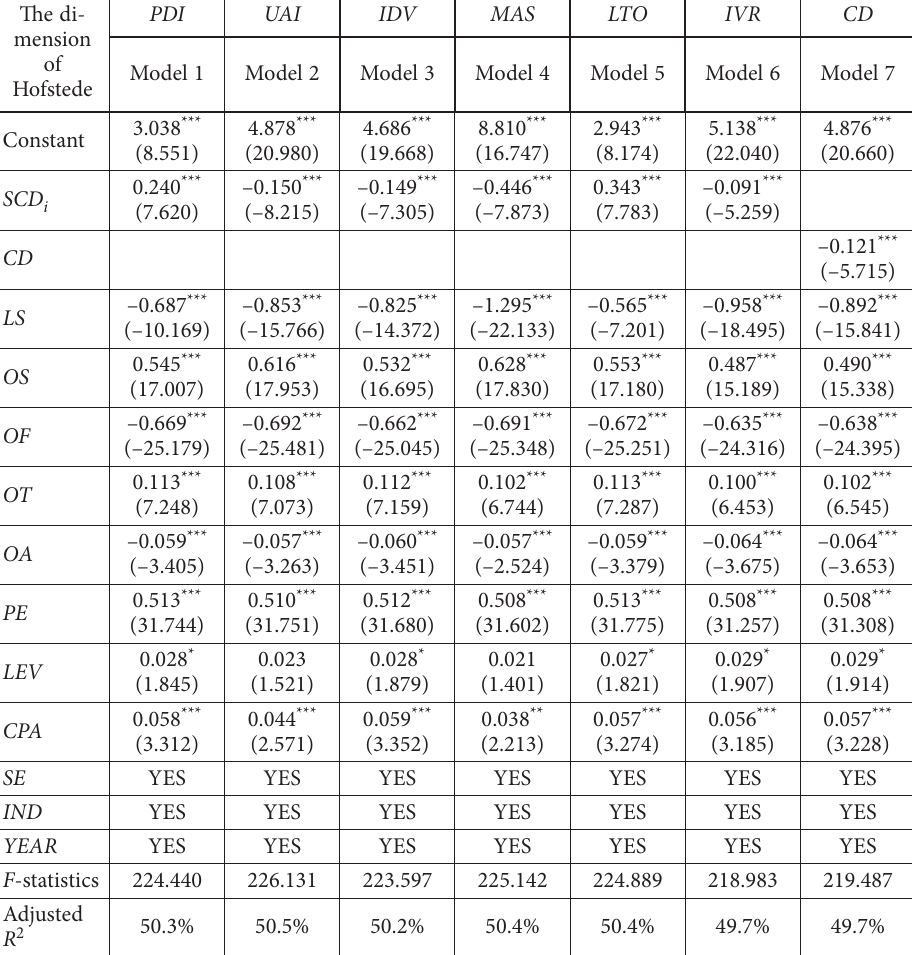
Table 2. Regression results of Hofstede’s culture on IPO underpricing (source: authors’ calculation) The di- mension